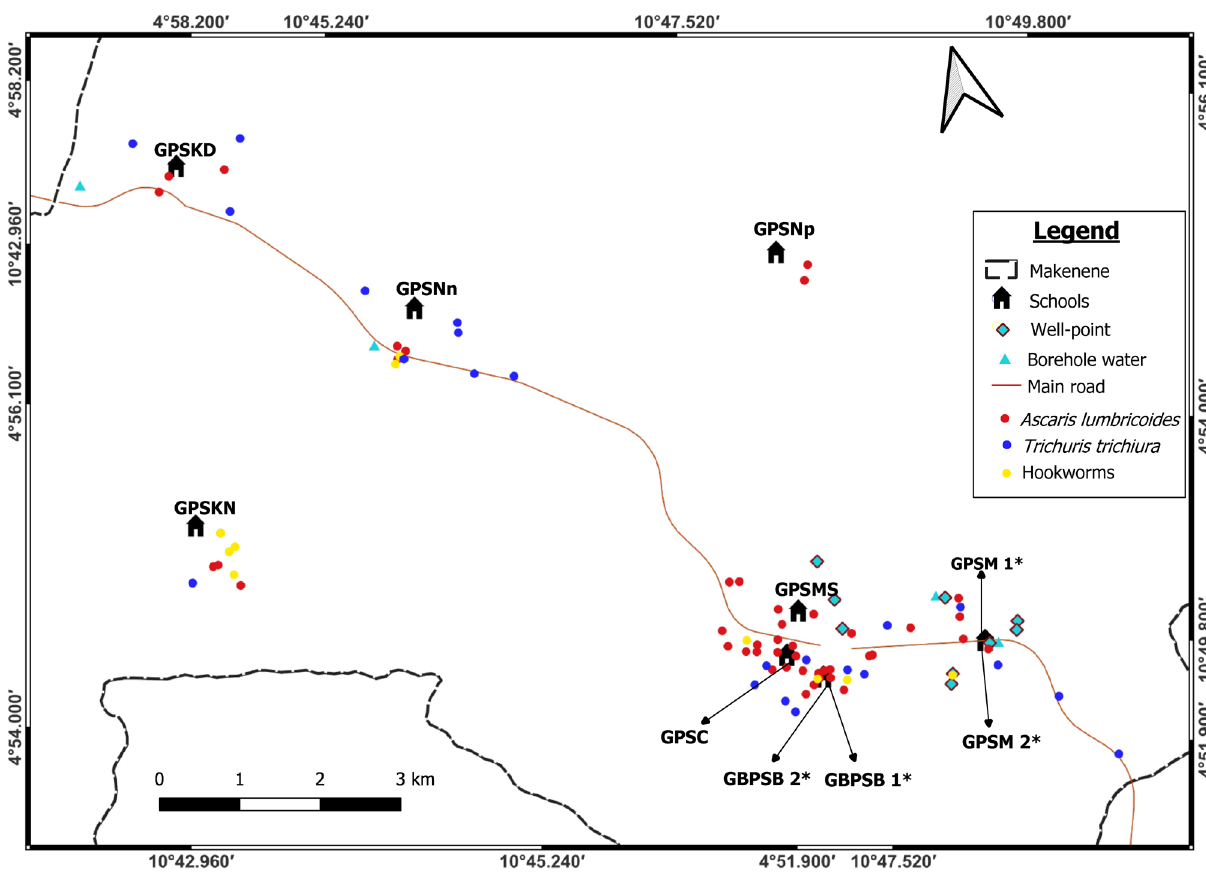
Figure 2. Map showing spatial distribution of different species of soil-transmitted helminths (*both schools are hosted on the same building). GBPSB1: Government Bilingual Primary School of Baloua Group 1; GBPSB2: Government Bilingual Primary School of Baloua Group 2; GPSM1: Government Primary School of Makenene Group 1; GPSM2: Government Primary School of Makenene Group 2; GPSNn: Government Primary School of Nyokon; GPSKD: Government Primary School of Kinding Nde; GPSKN: Government Primary School of Kinding-Ndjabi; GPSMS: Government Primary School of Mock-Sud; GPSC: Government Primary School of Carrière; GPSNp: Government Primary School of